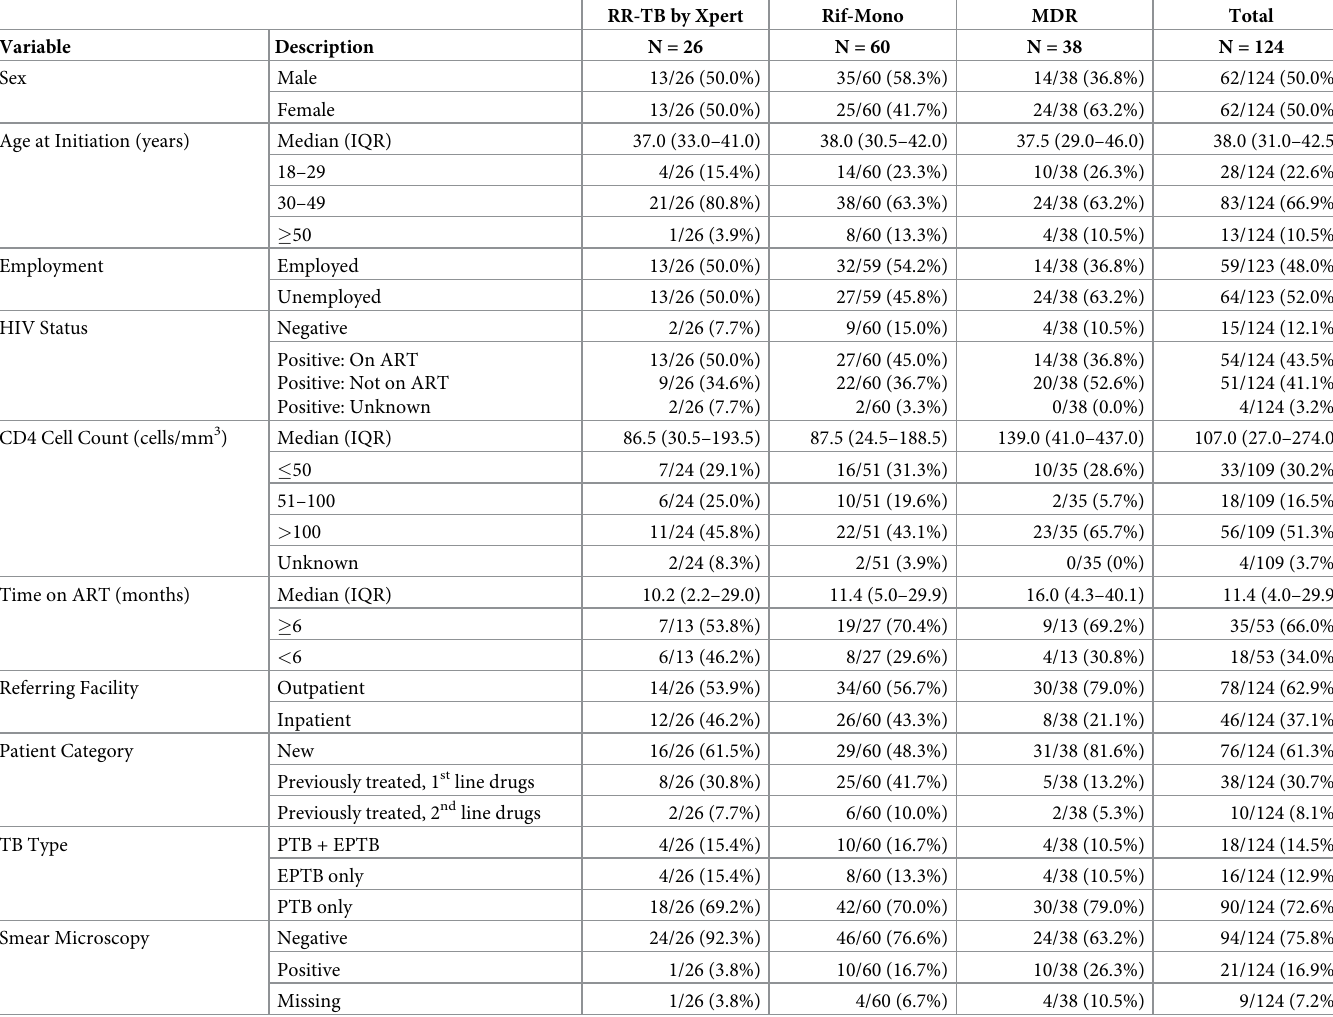
Table 1. Baseline demographic and clinical characteristics of DR-TB patients included in 36 month outcomes analysis (n =